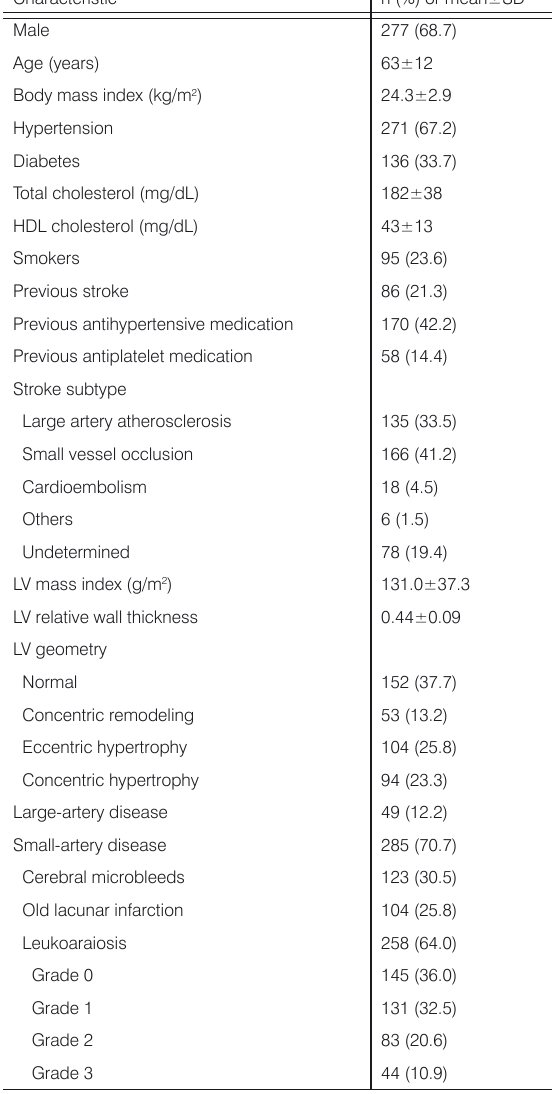
Table 1. Baseline characteristics of 403